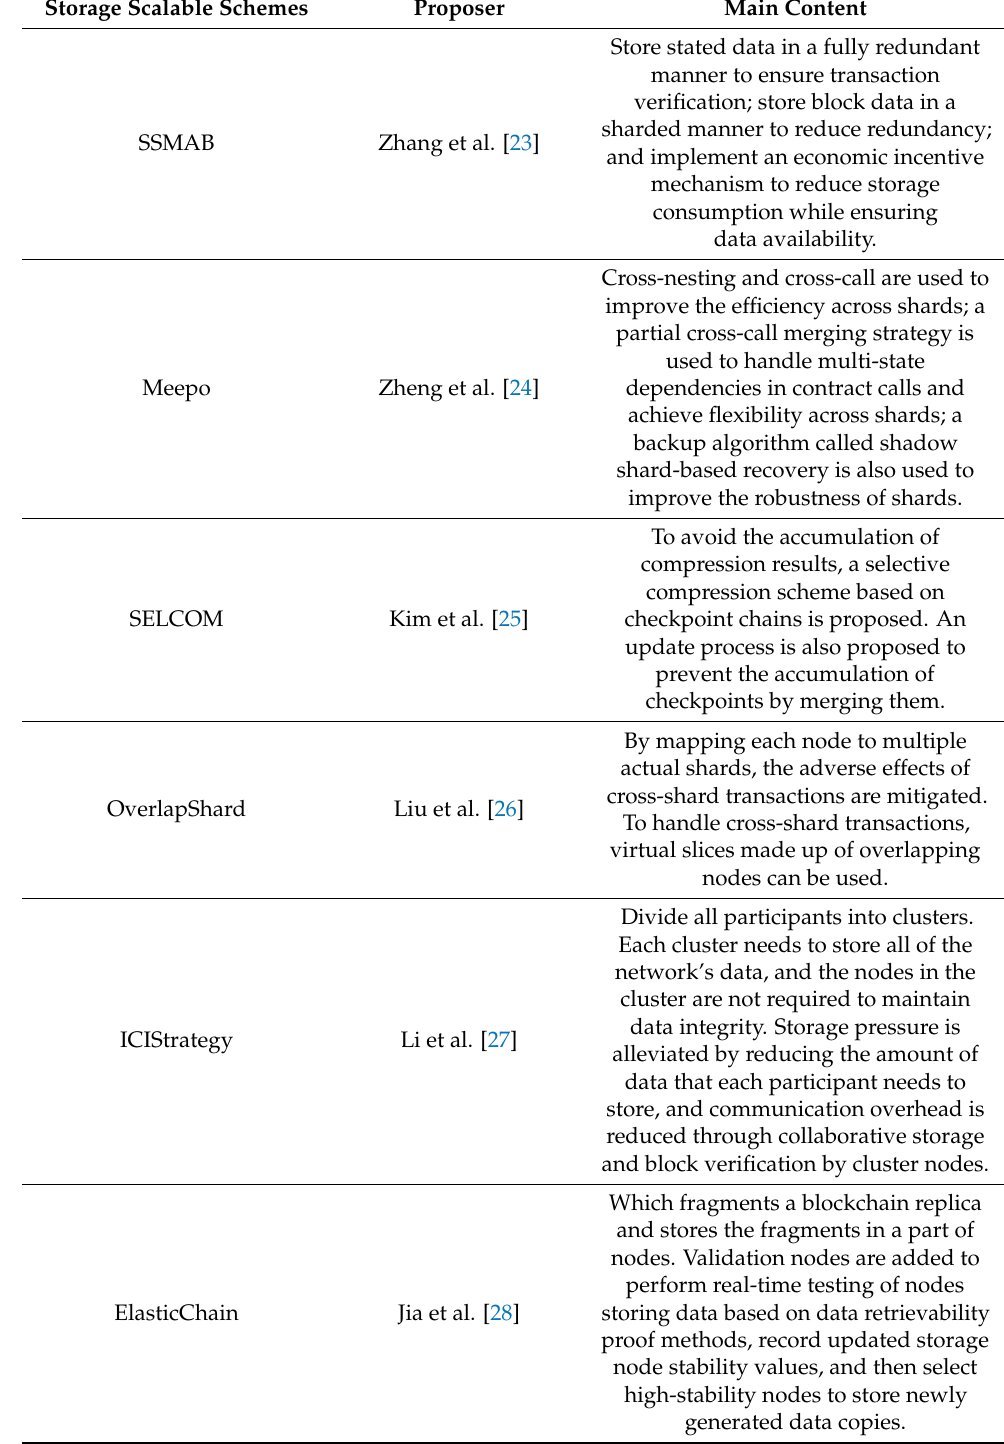
Table 1. Blockchain storage scalable schemes